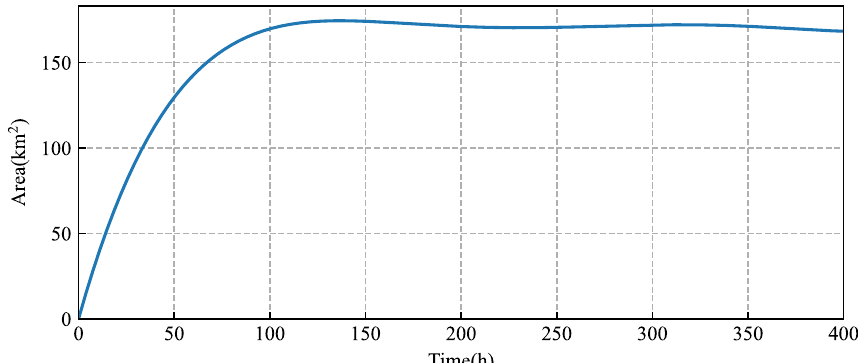
Fig. 7 “92.8” flood inundation area time